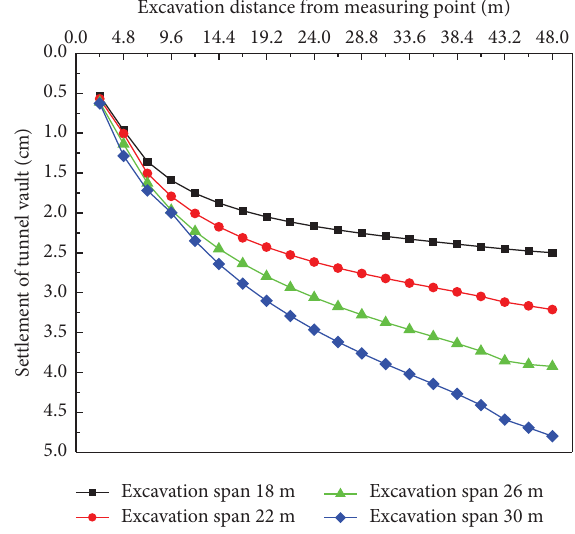
Figure 5: Settlement of tunnel vault with diferent excavation spans.